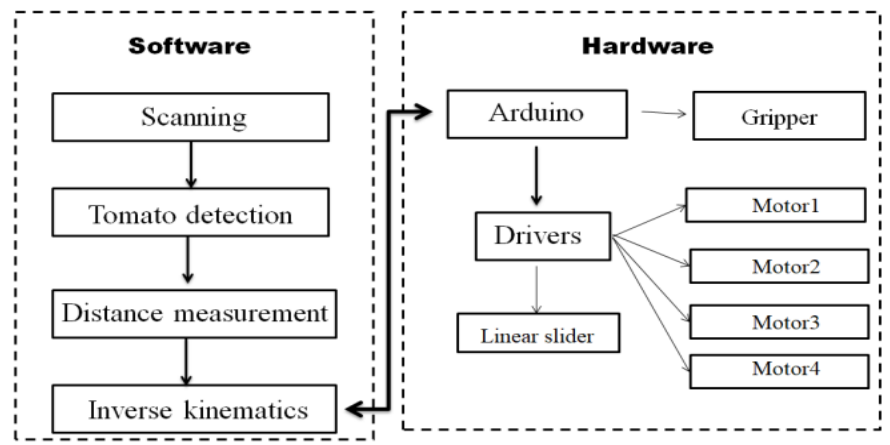
Figure 21. TakoBot control architecture.